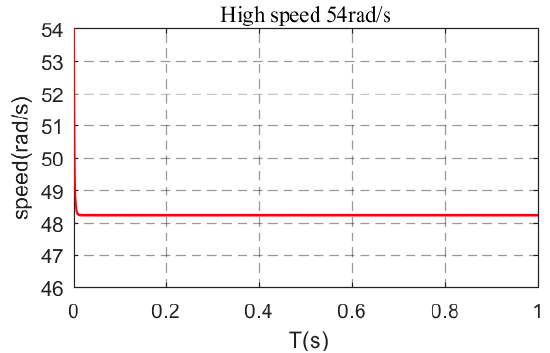
Figure 12. Results of sliding mode control under high speed.